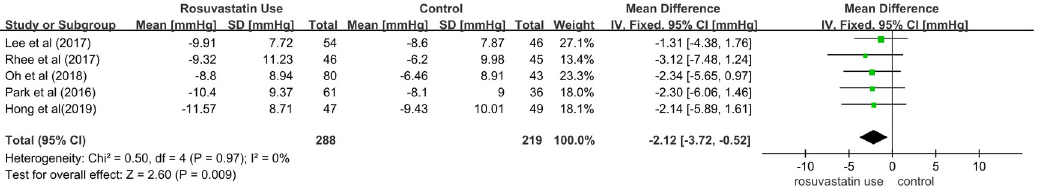
Fig 2. Pooled mean differences for the outcomes of diastolic blood pressure changes in patients with hypertension receiving rosuvastatin therapy vs. placebo or standard